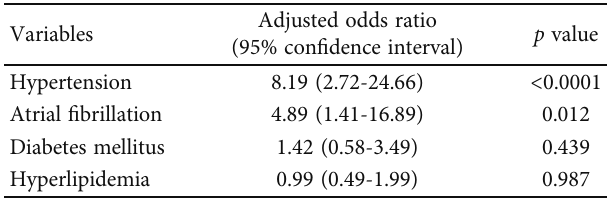
Table 5: Logistic regression analysis of risk factor of hemorrhagic